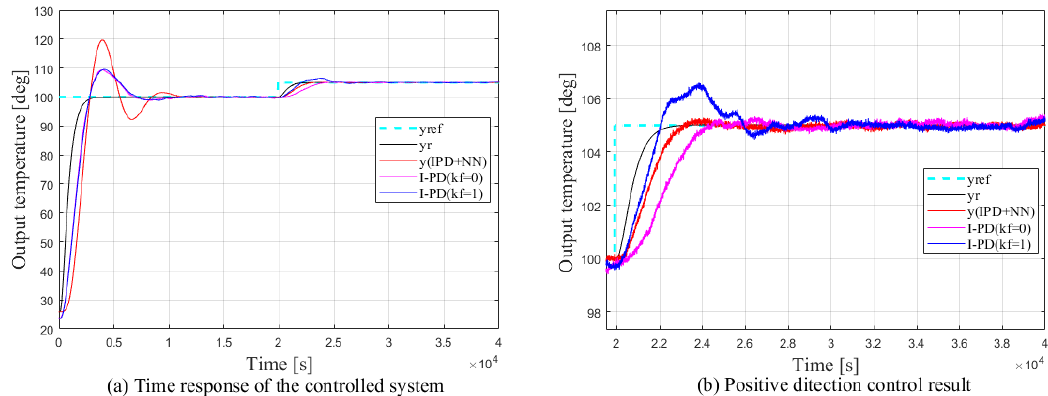
Figure 9. Experiment results. ( a ) Time response for the controlled system and ( b ) results of positive direction control for proposed control system and conventional I-PD control system for temperature increase from 100 ◦ C to 105 ◦ C obtained from experiments.